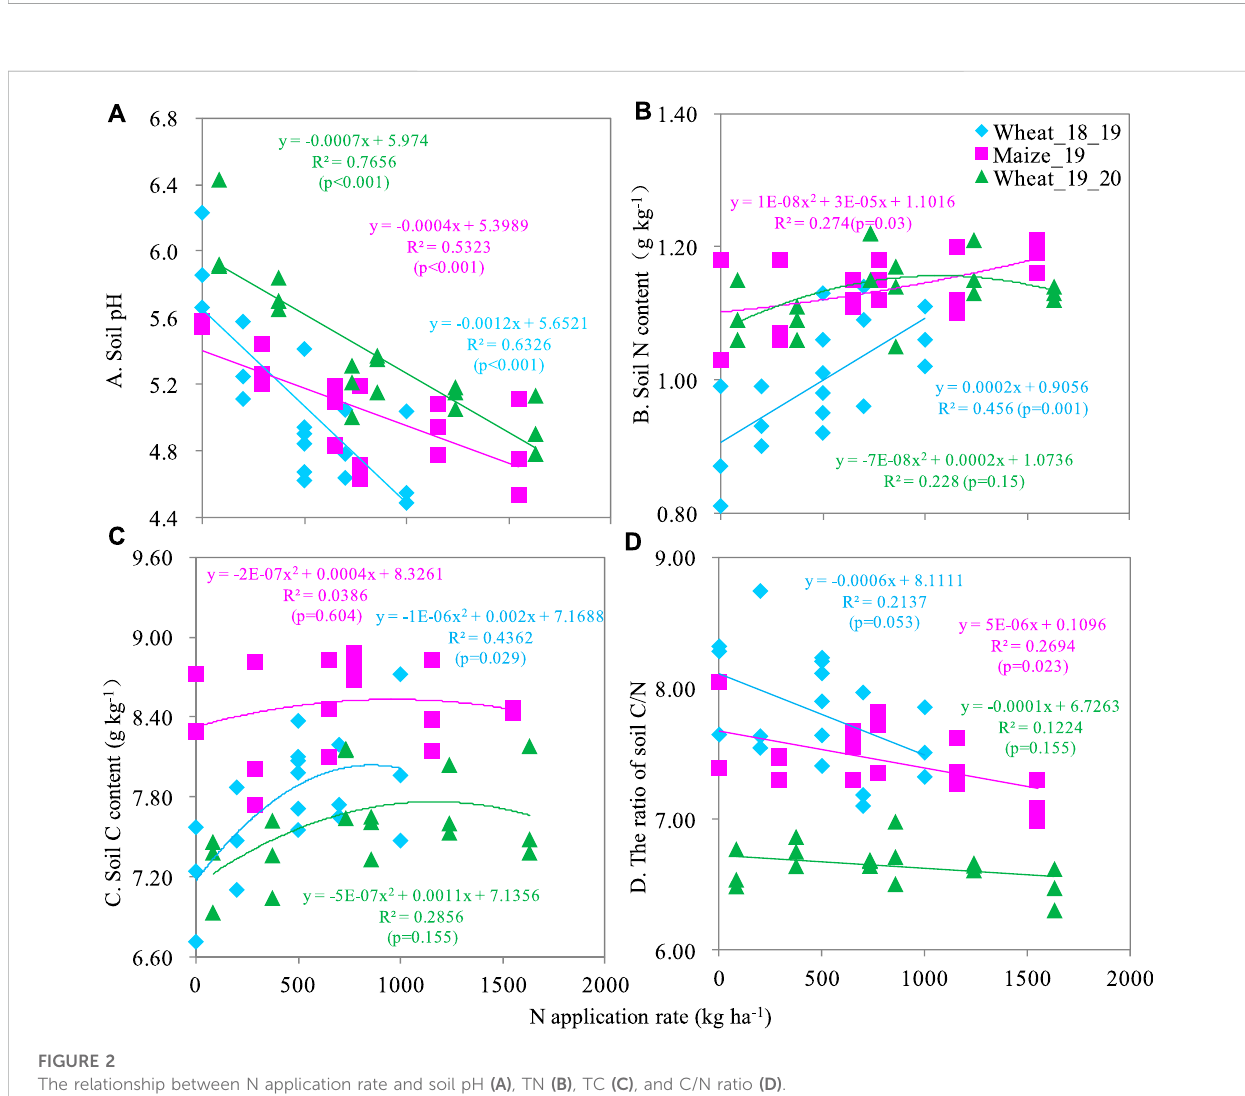
FIGURE 2 The relationship between N application rate and soil pH (A) , TN (B) , TC (C) , and C/N ratio (D)